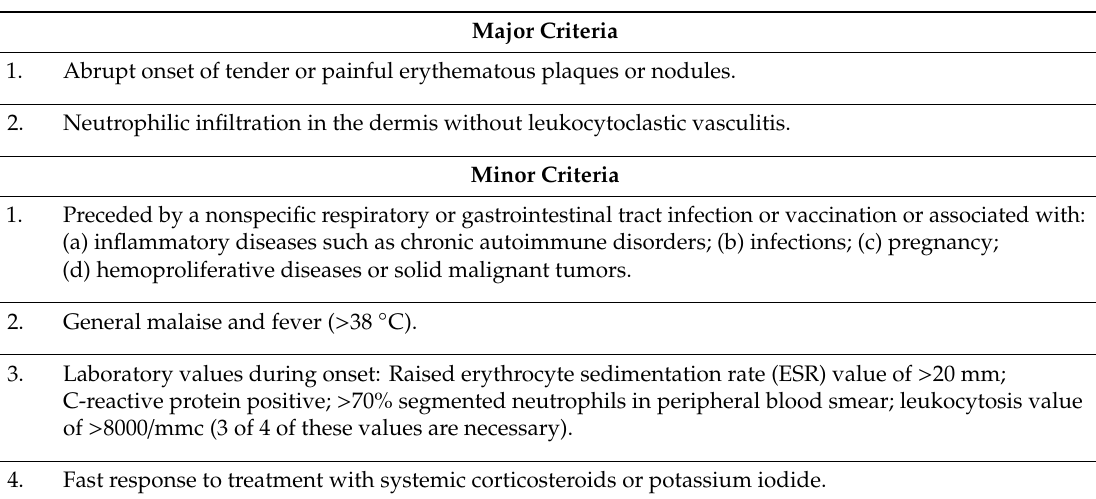
Table 1. Classical Sweet’s syndrome: Proposed diagnostic criteria.